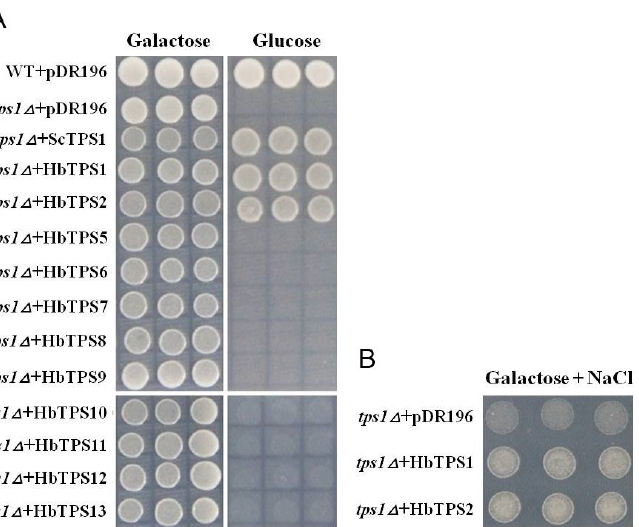
Figure 4. Complementation assay identifies two active HbTPS isoforms that confer salt tolerance in yeast. ( A ) Complementation assay of 12 HbTPS proteins in yeast tps1 mutant grown on SD medium with galactose or glucose. Three types of control strains were included, i.e., wild-type yeast with the empty pDR196 (WT+pDR196), yeast mutant with the ScTPS1 expression construct ( tps1 Δ + ScTPS1 ), and yeast mutant with the empty pDR196 ( tps1 Δ +pDR196). ( B ) Identical amounts of cells from yeast tps1 mutants harboring various constructs were spotted on galactose medium supplemented with 1 mol/L NaCl. The yeast cells were grown at 30 °C for 2 days.